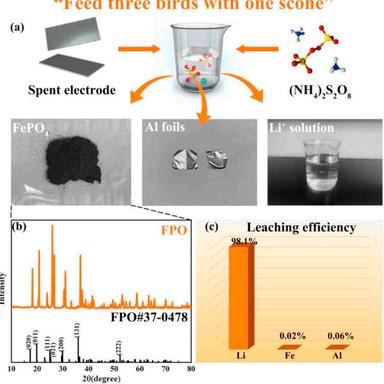
(a) Schematic diagram of "feed three birds with one scone" separation, (b) XRD patterns of FPO, and (c) leaching efficiency of each metal element.